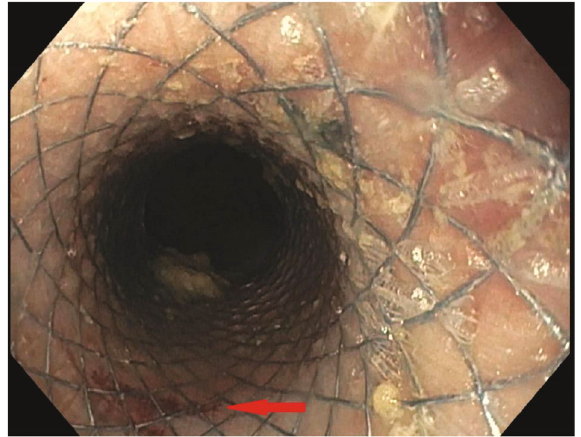
Figure 4: Endoscopic repair with a stent. The red arrow indicates the